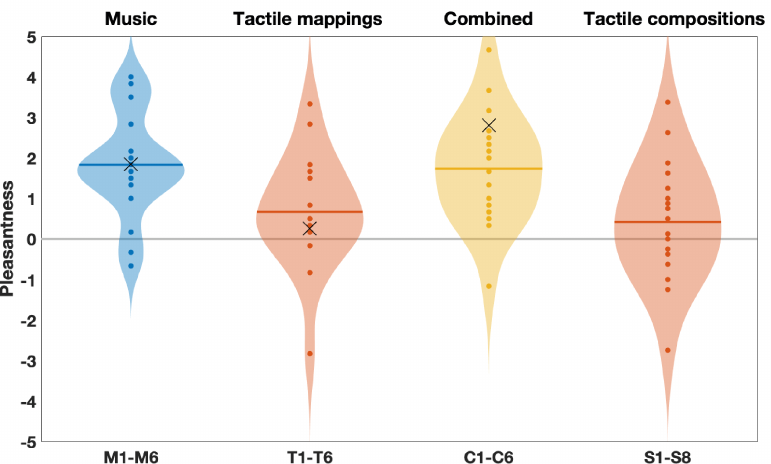
Figure 7. Results of Experiment 2 with Pump-and-Vibe. Mean pleasantness response of each participant across the music stimuli (M1–M6, auditory only), tactile music mappings (T1–T6, tactile only), combined stimuli (C1–C6, auditory and tactile) and tactile compositions (S1–S8, tactile only). M7, T7 and C7 are shown separately with X markers since T7 is a randomly generated